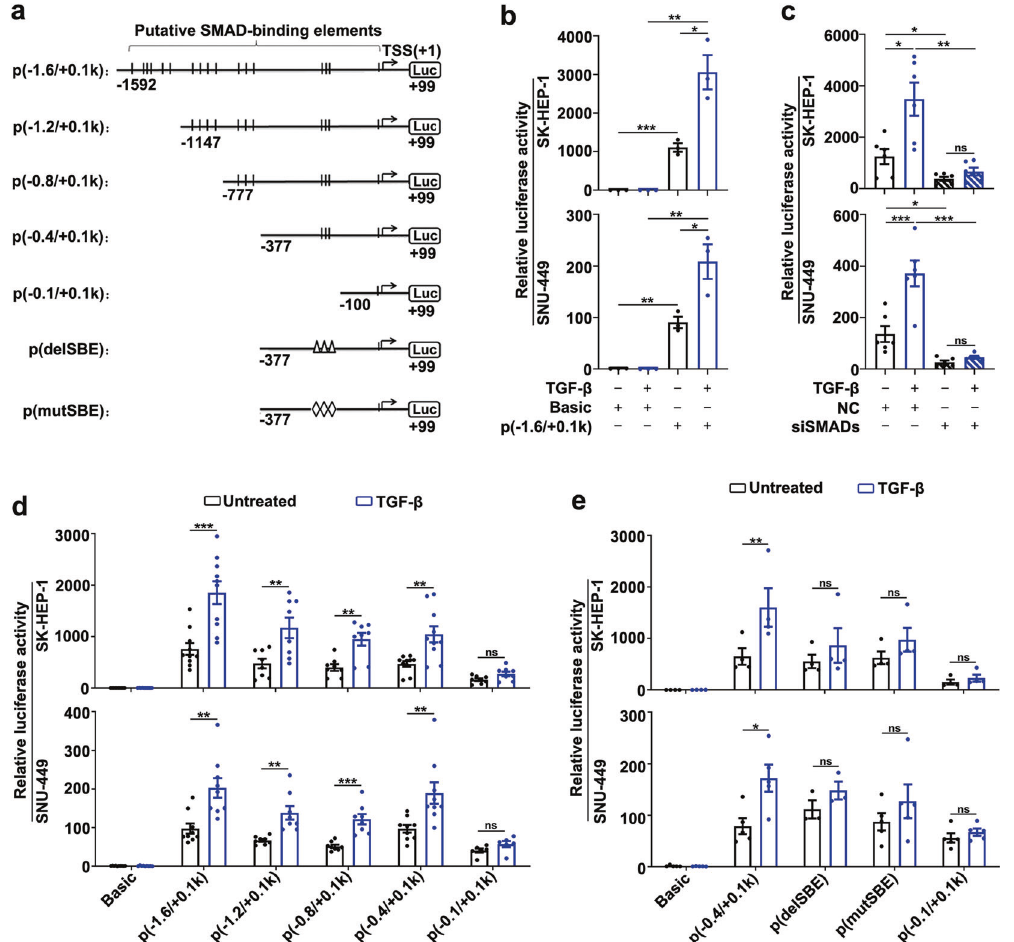
Fig. 2 The lnc-UTGF promoter is activated by the TGF- β /SMAD signaling. a Schematic diagram of fi re fl y luciferase reporters carrying the indicated DNA fragments of the lnc-UTGF promoter. Arrow designates the transcription direction of lnc-UTGF. Short vertical line: the putative SMAD-binding element (SBE). Triangle ( Δ ): deletion of the SMAD-binding element (delSBE). Rhombus ( ◊ ): mutation of the SMAD-binding element (mutSBE). TSS, transcriptional start site, Luc, luciferase gene. b TGF- β enhanced the activity of the lnc-UTGF promoter. Cells that were transfected with the indicated vectors for 36 h were untreated or treated with TGF- β for another 12 h. c Simultaneous knockdown of SMAD2/ 3/4 abrogated the effect of TGF- β in enhancing the lnc-UTGF promoter activity. Cells were transfected with NC or siSMAD2/3/4 for 12 h, followed by co-transfection with p( − 1.6/ + 0.1k) and pRL-CML vectors for 24 h, then untreated or treated with TGF- β for another 12 h. d Sequential 5 ′ -end deletion analysis showed that the − 0.4 to − 0.1-kb region of the lnc-UTGF promoter contained the TGF- β